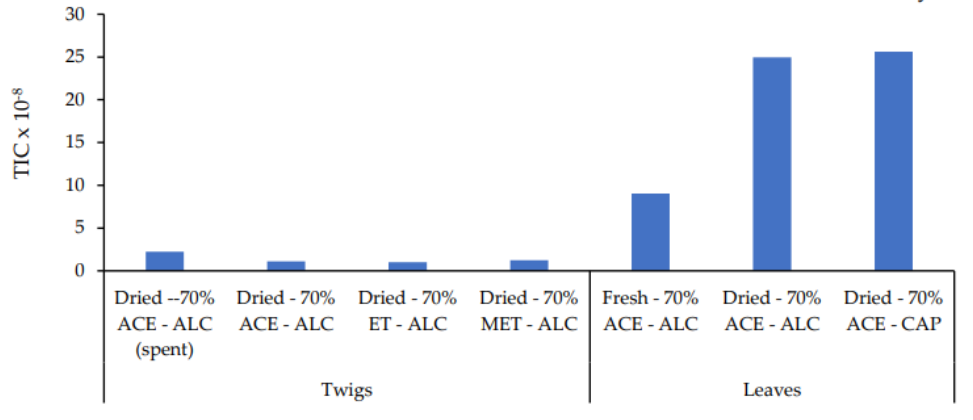
Figure 4. Absolute peak areas of phytol in the analyzed extracts; TIC: Total Ion